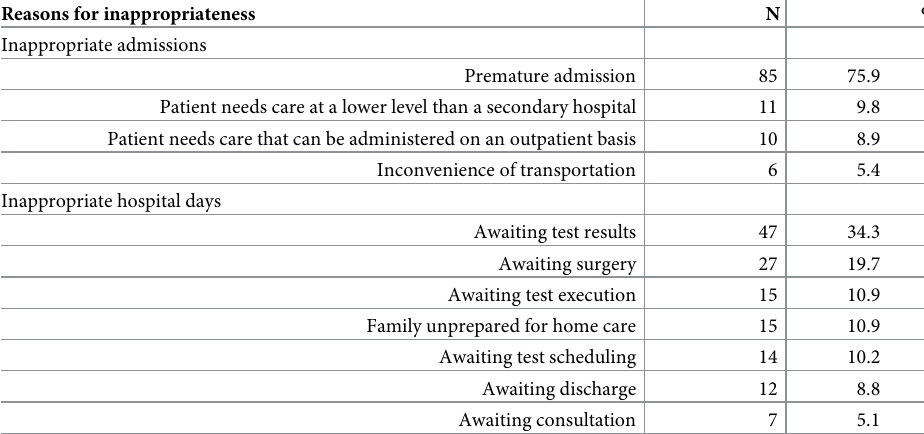
Table 5. Reasons for inappropriate admissions and hospital